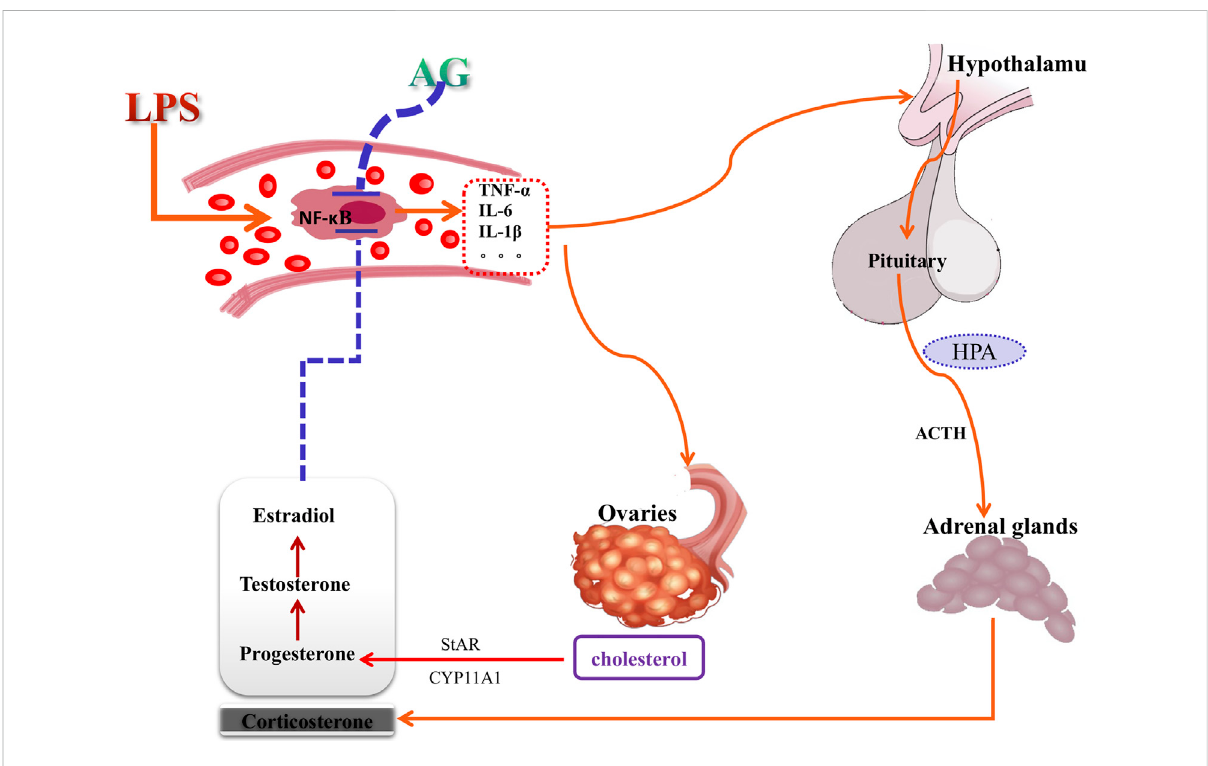
FIGURE 10 The mechanism of andrographolide (AG) acting on sex hormone production pathways. Red arrows indicate stimulation and blue vertical bars indicate inhibition. AG acting on sex hormone production may be mediated by anti-in fl ammatory action, and is an indirect